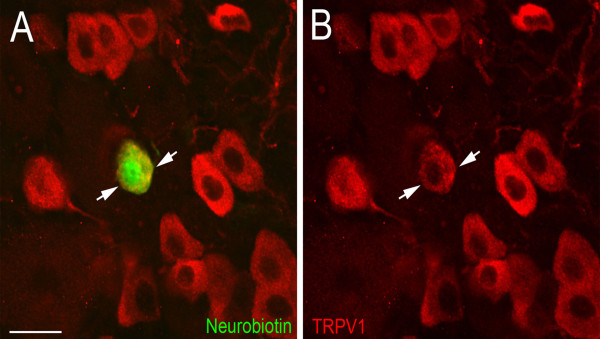
Example of TRPV1-positive CPM-fiber following inflammation. Light micrographs of a L3 DRG from the ex vivo recording preparation containing a neurobiotin-filled polymodal C-fiber (CPM) immunoreactive for TRPV1. A) A Neurobiotin labeled (green) CPM neuron (arrows) recovered from the ex vivo preparation overlaps with TRPV1 immunoreactivity (red). B) Immunostaining for TRPV1 (red) shows that the same neurobiotin-filled CPM neuron in A is immunopositive for TRPV1 (arrows). Scale bar, 20 μm.